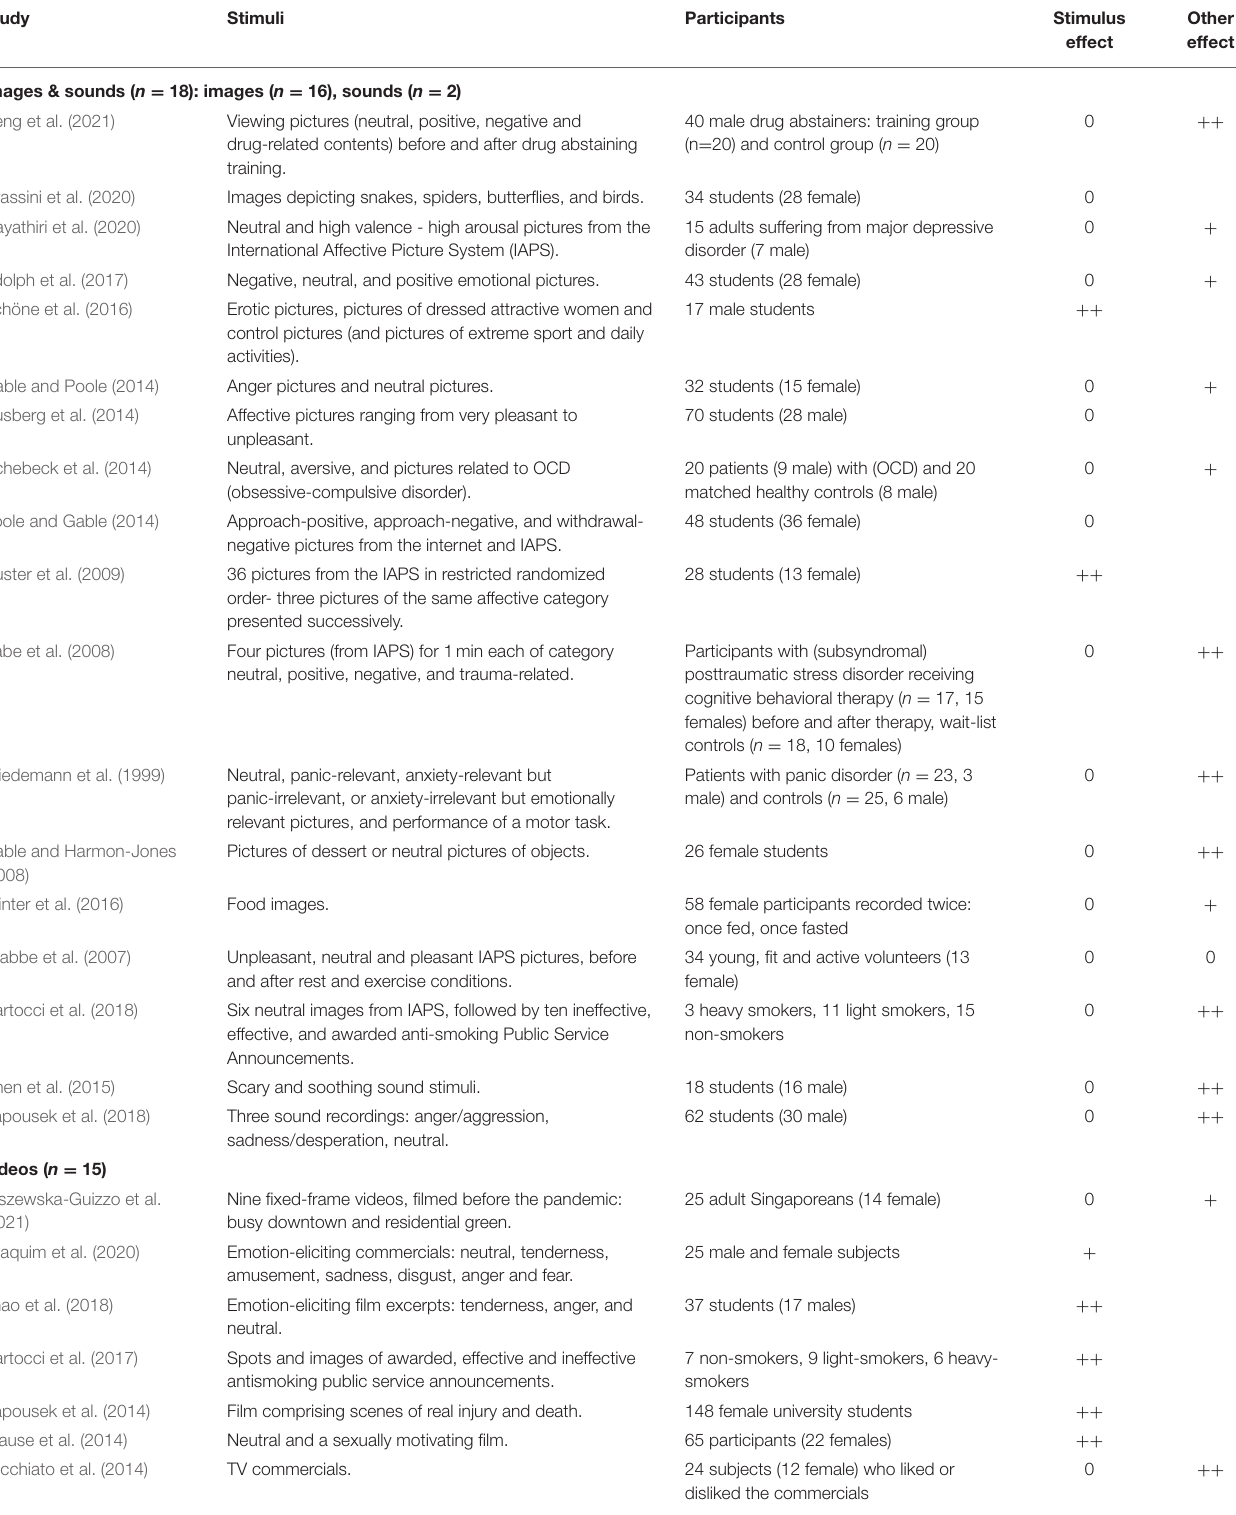
TABLE 1 | Overview of studies arranged by stimulus types with (the hypothesized) approach-avoidance effect indicated by ++ (significant), + (trend) and 0 (none) of the stimulus alone, and/or other effects involving the stimulus. Note that many studies were set up for studying the ‘other’ effect (e.g. interaction with person characteristics or interaction between stimuli and other condition).